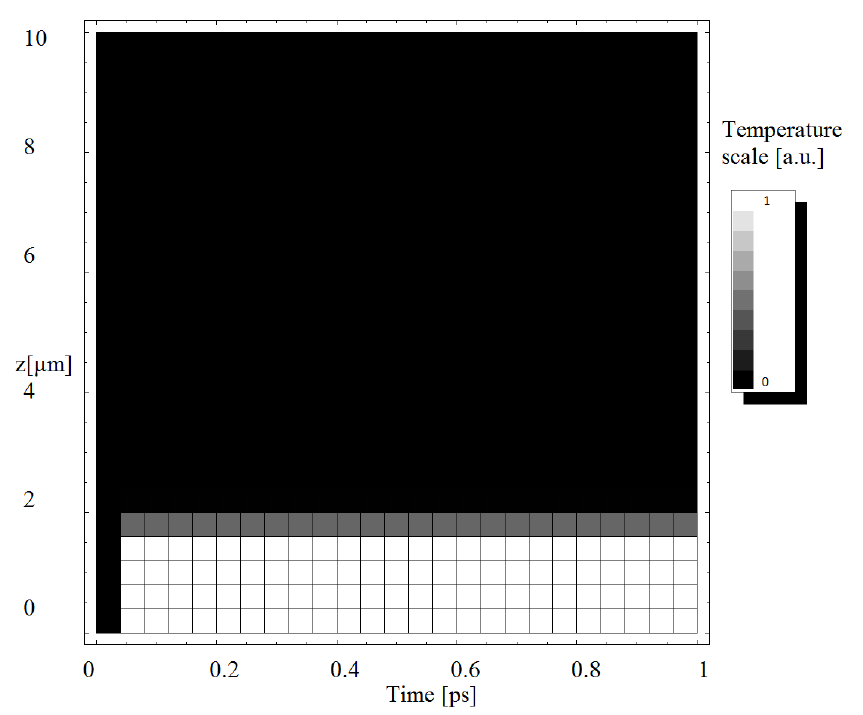
Figure 4. Electron temperature density evolution in time and space in the case of one laser pulse of 100 fs irradiation of an Au surface for τ = 1 ps relaxation time vs. time (1 ps).